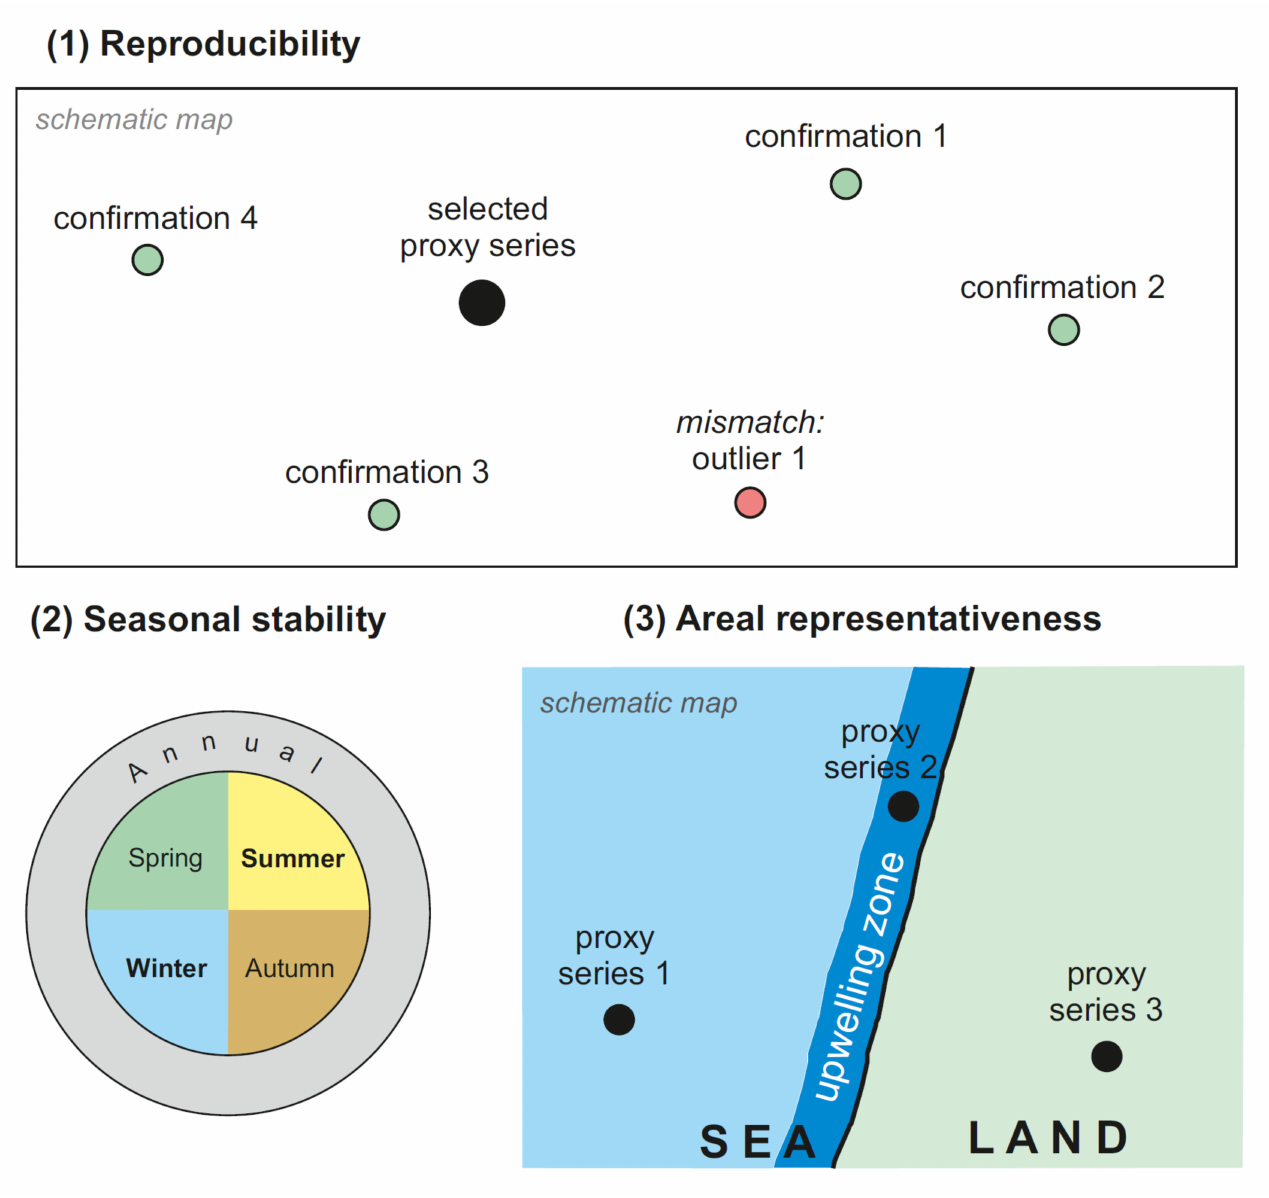
Figure 3. Quality criteria for palaeotemperature proxy selection (see text for